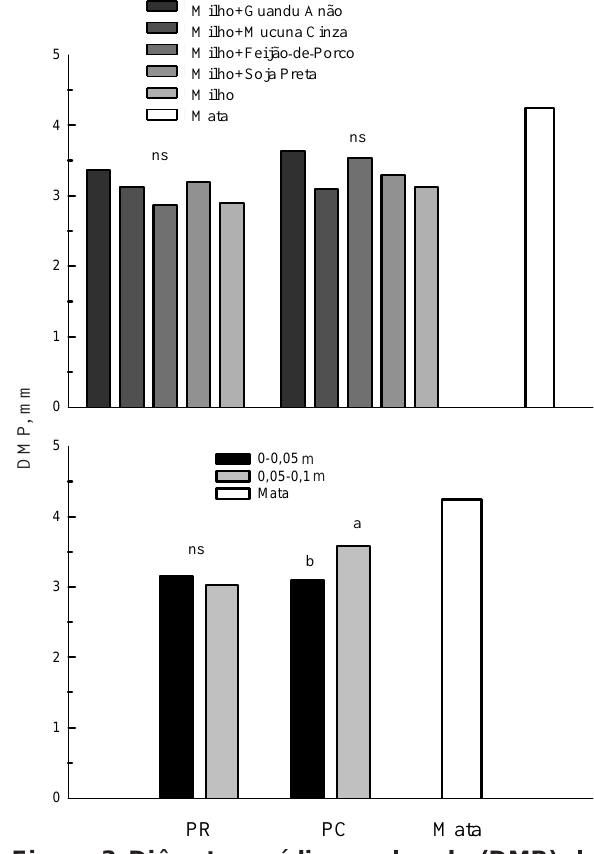
Figura 3. Diâmetro médio ponderado (DMP) de agregados do solo, na camada de 0–0,1 m de profundidade, nos sistemas de cultura com preparo reduzido (PR) e convencional (PC) e na mata nativa. Para comparar as profundidades (0–0,05 e 0,05–0,1 m), foi calculada a média dos cinco sistemas de culturas em cada sistema de preparo. Letras minúsculas diferentes indicam diferença significativa (Duncan a 5